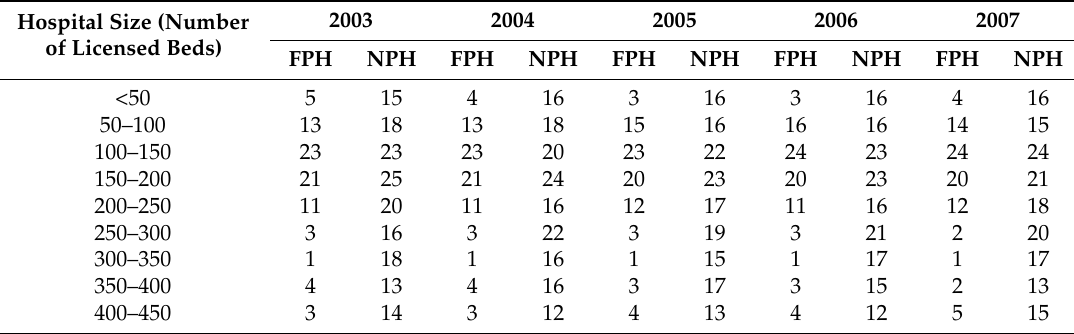
Table 1. Number and Percentage of California General Hospitals by Ownership